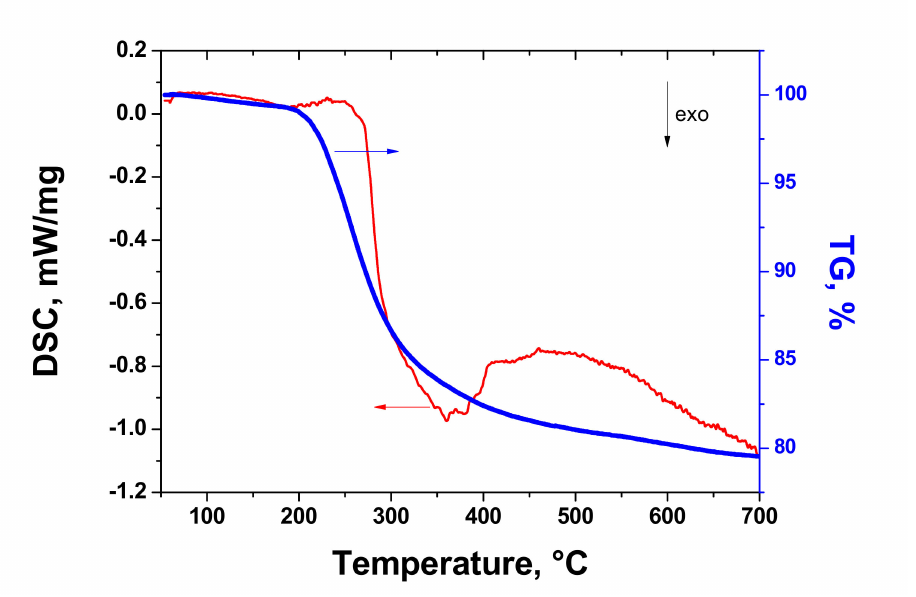
Figure 2. TG/DSC curves of intercalated graphite (Ar, 2.5 ◦